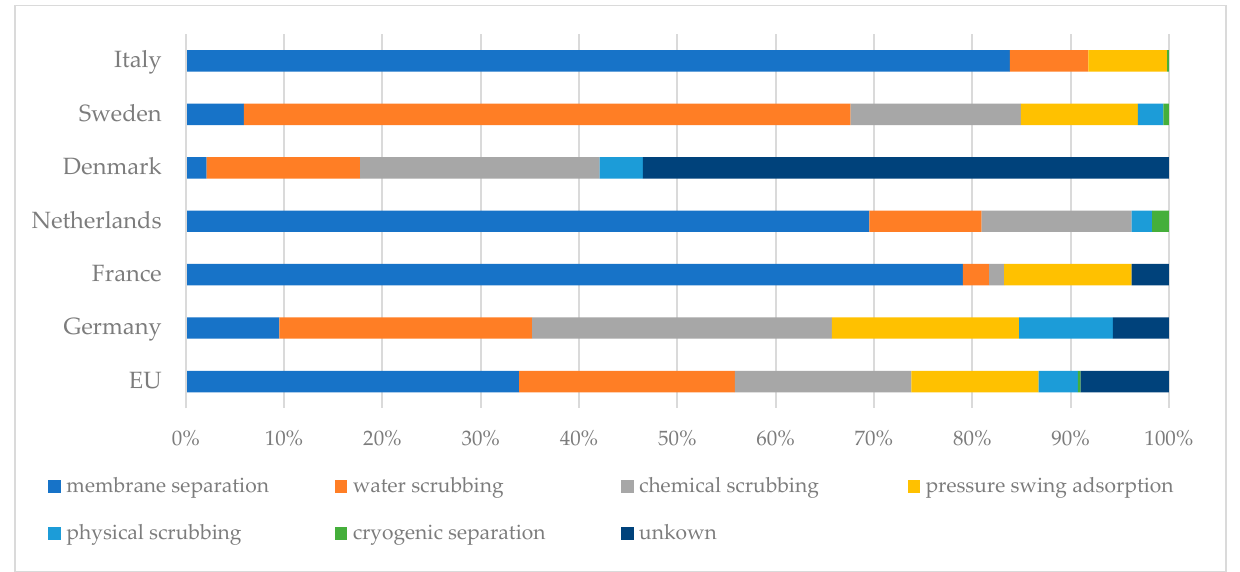
Figure 6. The structure of biomethane upgrading methods. Source: own elaboration based on EBA [6].